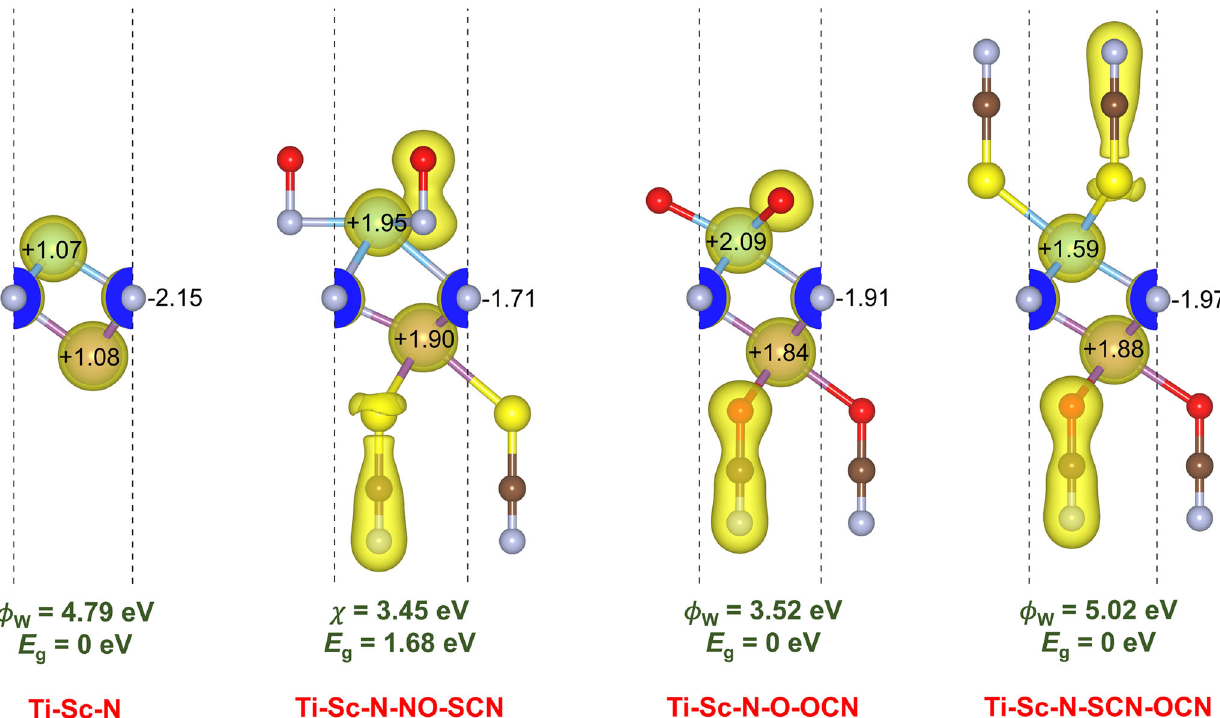
Fig. 1 Variation of work function and band gap of MXene with suitable functionalization. Along with these two quantities, HSE (Heyd – Scuseria – Ernzerhof) hybrid functional-calculated Bader charges for the metal and nitrogen atoms are mentioned for bare metal, functionalized semiconductor, and functionalized metal MXenes with low and high work functions. The yellow and blue clouds represent the HSE-calculated charge densities. The isosurface level is set at 0.17 e Å − 3 . The dashed lines represent the unit cells. The sky blue, blue, purple, red, brown, and yellow balls represent Ti, N, Sc, O, C, and S